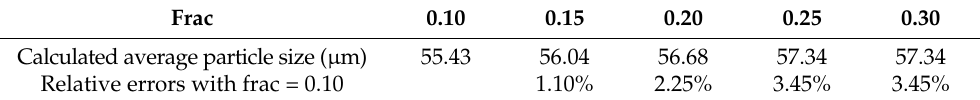
Table 3. Relative errors of the calculated average particle size with different frac values at 7.79 ms.